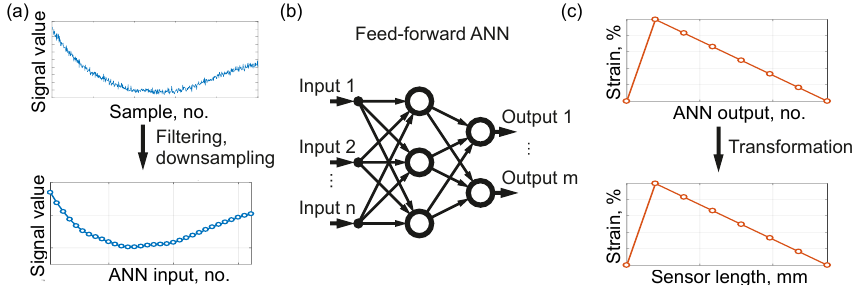
Figure 4. Procedure of the proposed mapping approach: processing of ETDR signal as ANN input data (a) , conceptual design of the ANN (b) , and interpretation of the ANN output as strain profiles (c) .